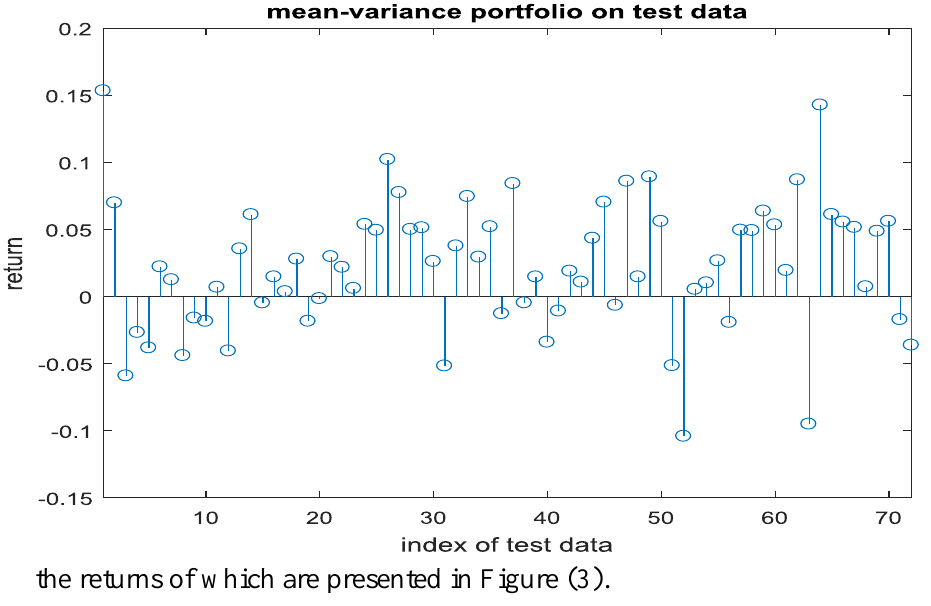
Figure 3. Markowitz portfolio returns on test data